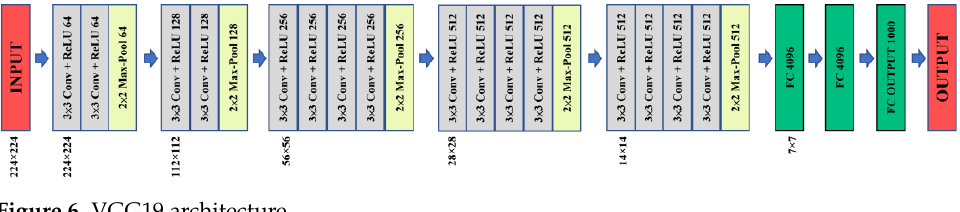
Figure 6. VGG19 Figure 6. VGG19 architecture. Figure 6. VGG19 architecture. Figure 6. VGG19 architecture.